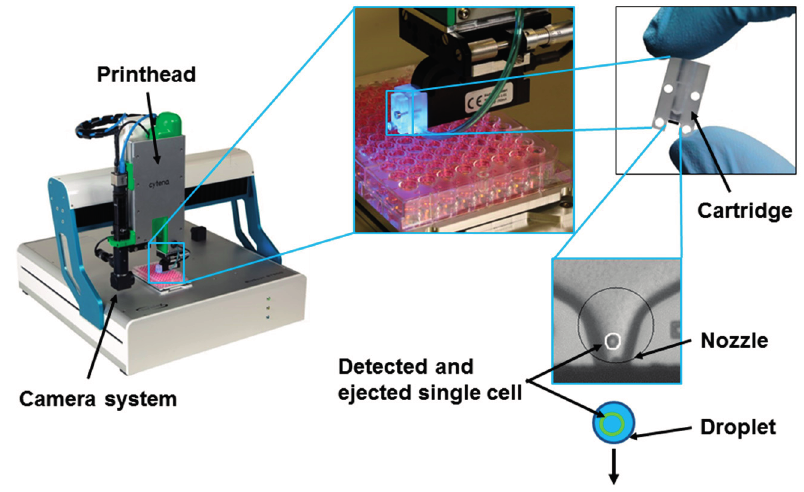
Figure 6. Single-cell printer (SCP) for single-cell isolation. A microfluidic dispenser chip integrated in a polymer cartridge is filled with cell suspension. An automated object recognition algorithm detects cells in the dispenser nozzle prior to the dispensation. This allows for ejection of droplets containing one single-cell only and their deposition in direction of the arrow on various substrates, such as micro-well